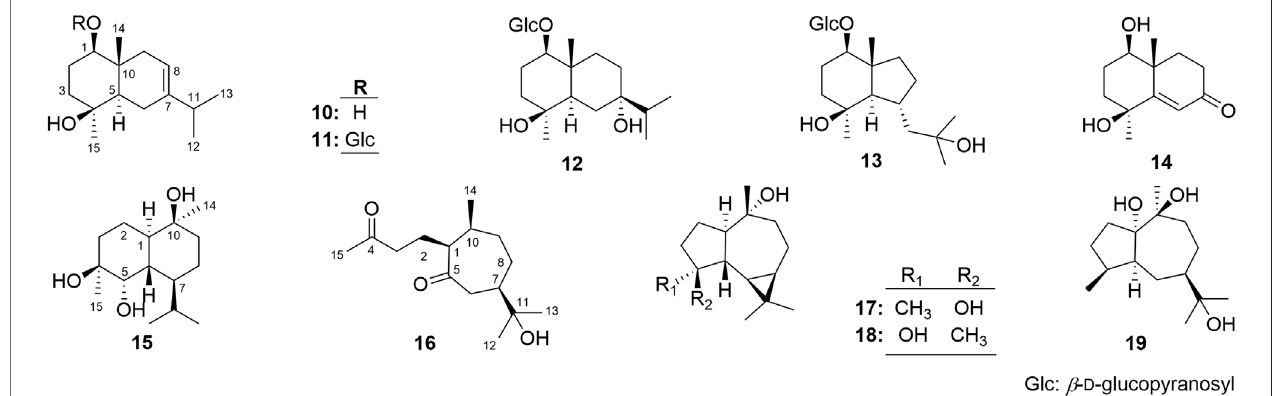
FIGURE 2 | The structures of known compounds 10 – 19 .